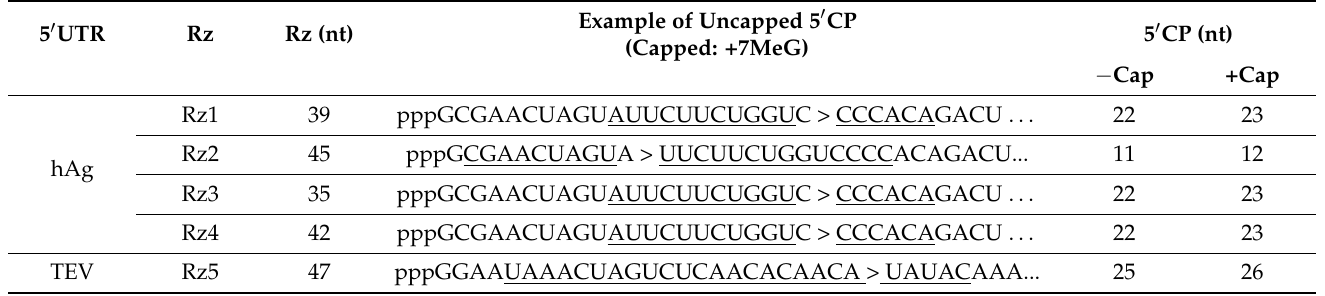
Table 2. Length of the designed ribozymes and example cleavage